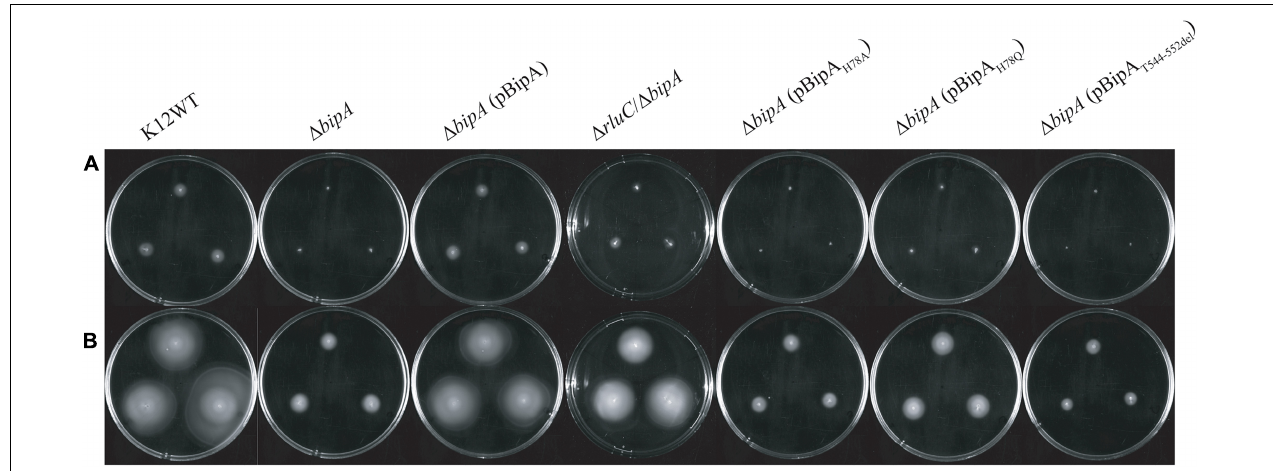
FIGURE 2 | The effect of BipA on swimming motilities of various strains of E. coli K12 BW25113 after (A) 24-h incubation and (B) 48-h incubation. The agar plate-based assay was employed, and it was assessed by the development of chemotactic ring. (A) After 24-h incubation at room temperature (suboptimal temperature), cells with bipA deletion showed no notable chemotactic rings except for cells with double mutations ( (cid:49) rluC / (cid:49) bipA ). Cells with the plasmid-borne BipA were compensated for the loss of genomic bipA and yielded chemotactic ring with similar size to the strain K12WT. The (cid:49) bipA strains expressing BipA mutants also demonstrated the lack of chemotactic ring except for the strain (cid:49) bipA (pCA24N-BipA H78 Q ), which showed slight development of chemotactic ring as compared to the (cid:49) bipA strain. (B) After 48-h incubation, all the strains developed chemotactic rings despite variations in size. The (cid:49) bipA strain expressing BipA mutants presented significant increase in chemotactic ring size, where the strain (cid:49) bipA (pCA24N-BipA H78 Q ) yielded chemotactic ring larger than the strains (cid:49) bipA (pCA24N-BipA H78 A and pCA24N-BipA T544_ D 552 d el ). The “p” in the bracket alone or preceding “BipA” represents plasmid